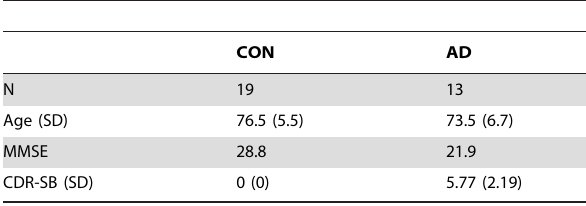
Table 1. Demographic and clinical